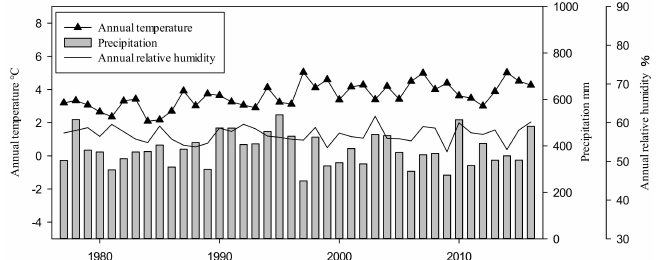
Figure 1. Annual temperature (T), relative humidity (RH) and precipitation (P) at the study site